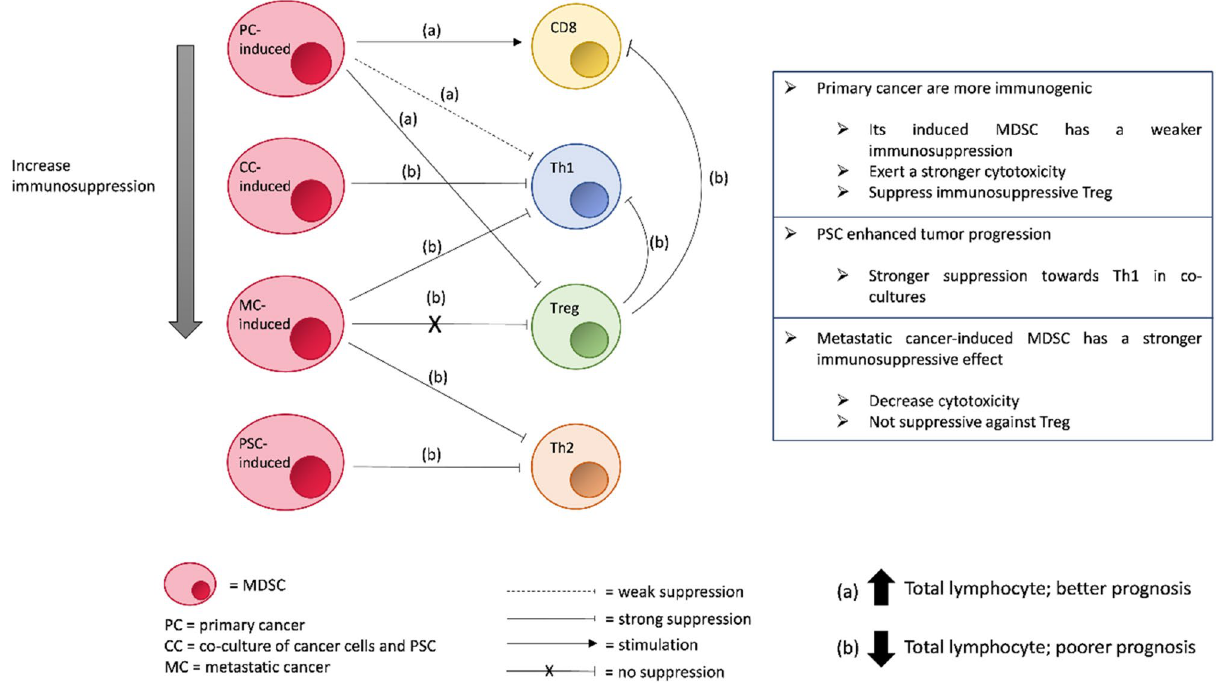
Figure 7. The effects of CM-induced MDSCs on each T cell